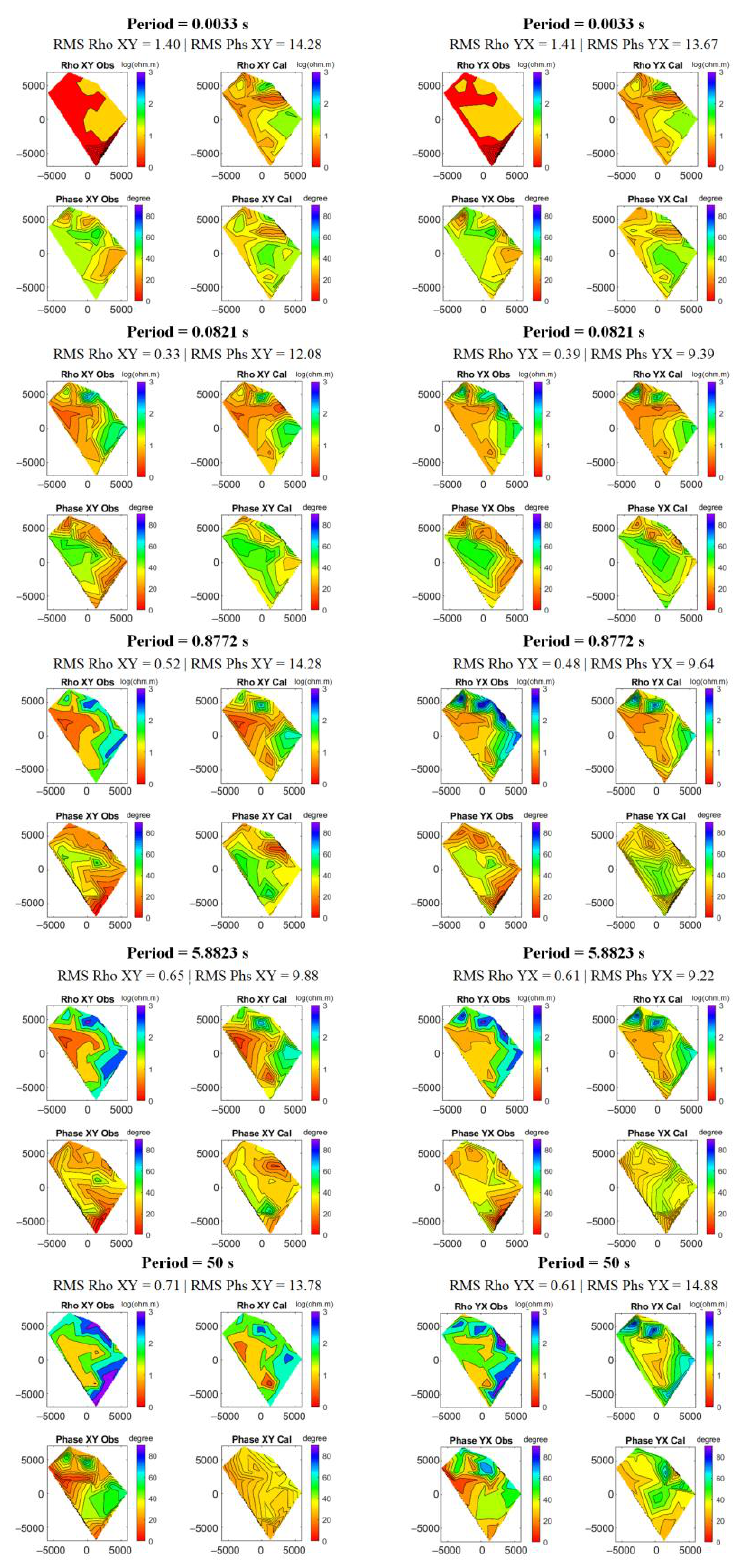
Figure 7. Comparison between the observed and calculated data for periods of 0.003 to 50 s. For the apparent resistivity maps, the lowest RMS value of 0.2 was yielded at a period of 0.0096 s, whereas the highest RMS value of 1.41 was yielded at 0.003 s. For the impedance phase maps, the lowest RMS value of 8.74 was yielded at 2.0408 s, whereas the highest RMS value of 14.88 was yielded at 50 s.